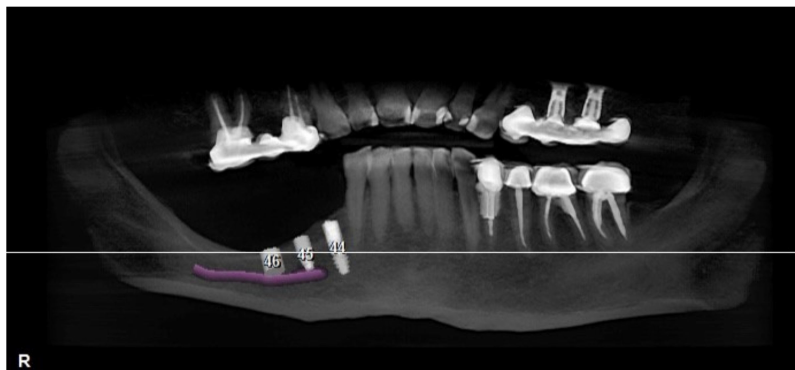
Figure 2. Panoramic radiograph showing the implant planning and nerve